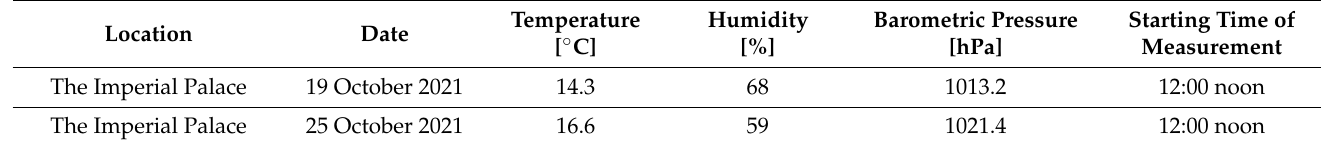
Table 3. Environmental conditions of measurement location in cloudy